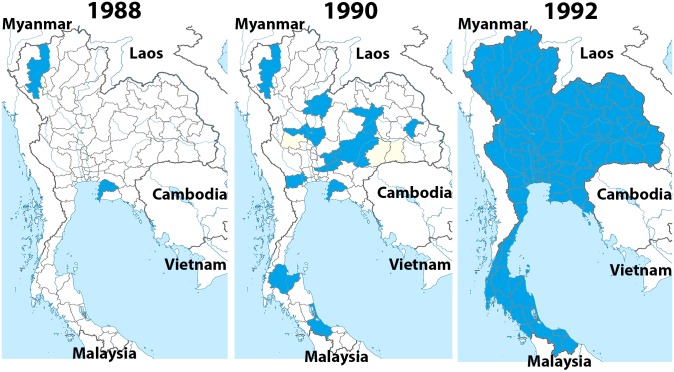
The implementation of universal HB immunization in 1988–1992.The Expanded Program on Immunization (EPI) began in two provinces, Chiang Mai and Chon Buri, in 1988, increased to 12 provinces in 1990, and covered the entire country by 1992.